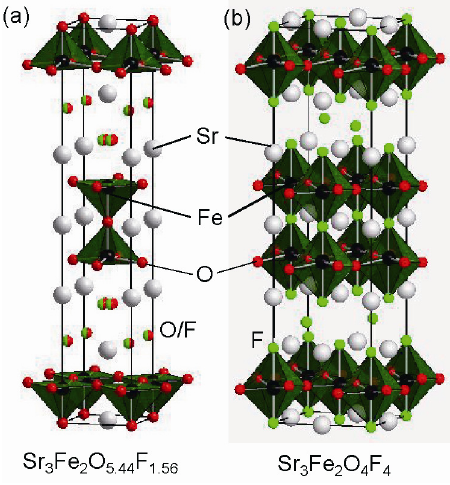
Fe O F , and ( b ) Sr 3 2 5.44 1.56